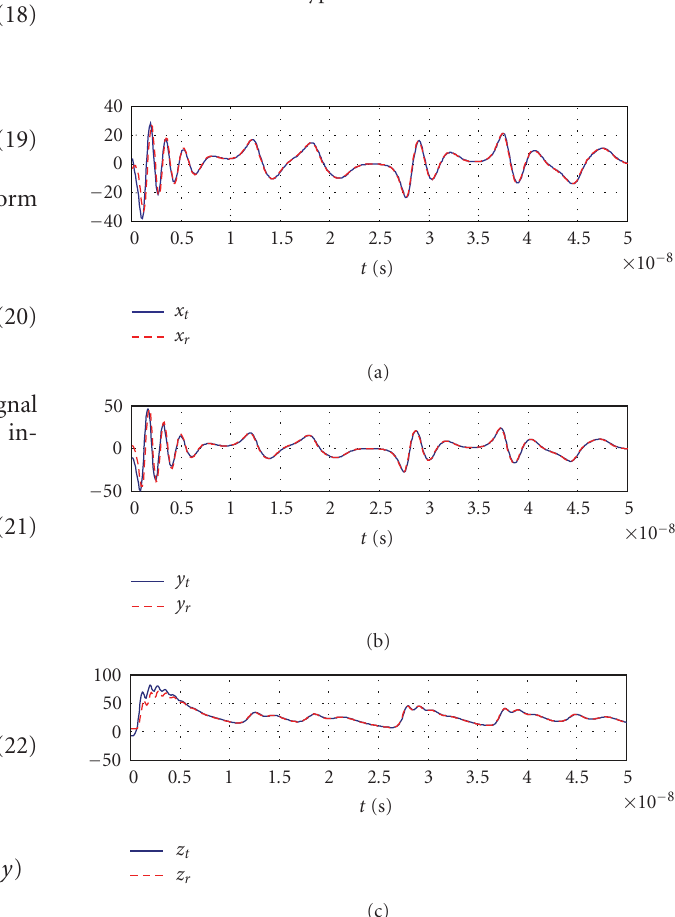
Figure 1: The typical unified chaotic attractors.